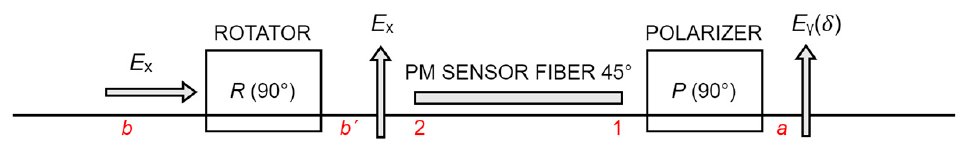
Figure 2. Arrangement of path a : a → 1 → 2 → b (cid:48) → b .